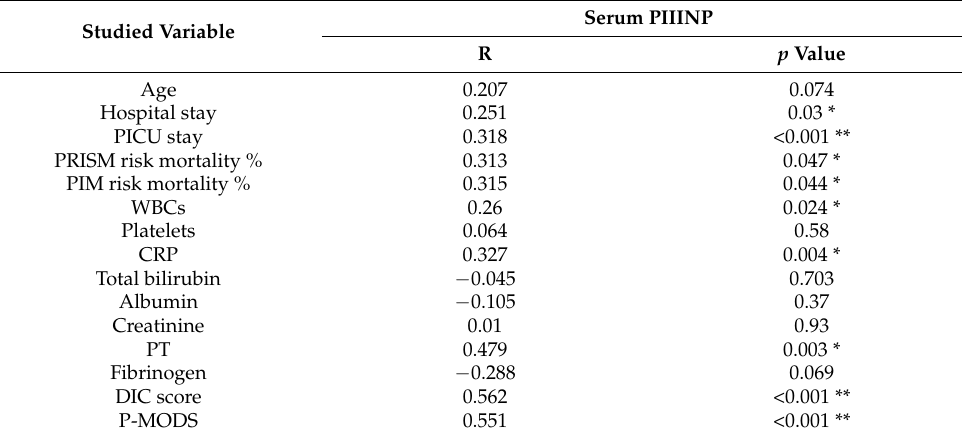
Table 4. Correlation between PIIINP level and other clinical parameters in the studied